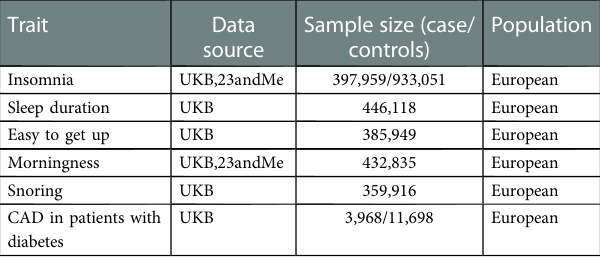
TABLE 1 Detailed information on data